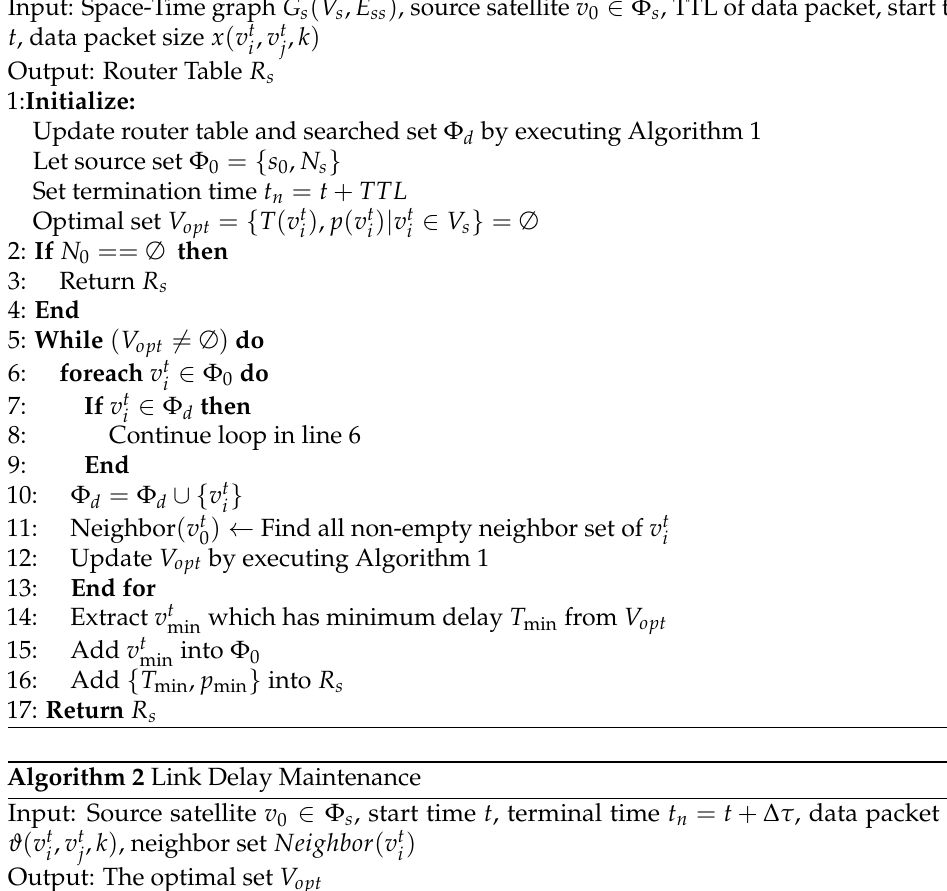
Algorithm 1 Time Interval Optimization-based Satellite Routing